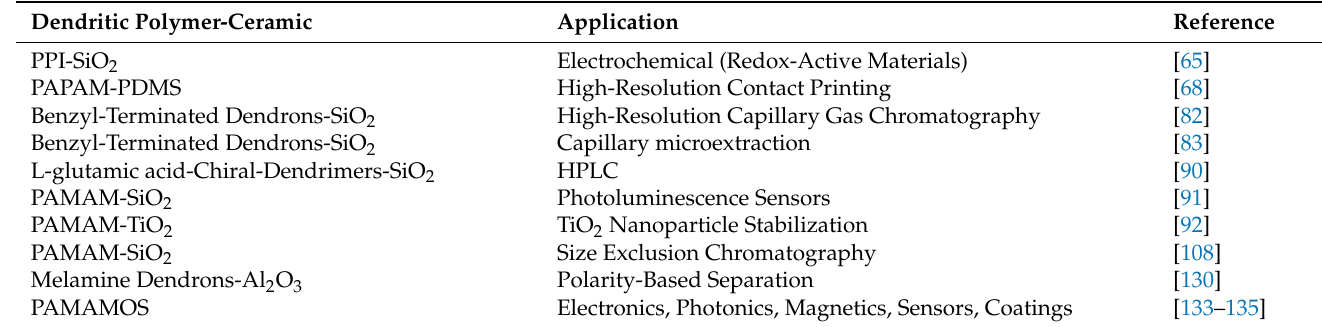
Table 1. General applications of ceramics/dendritic polymer composites.